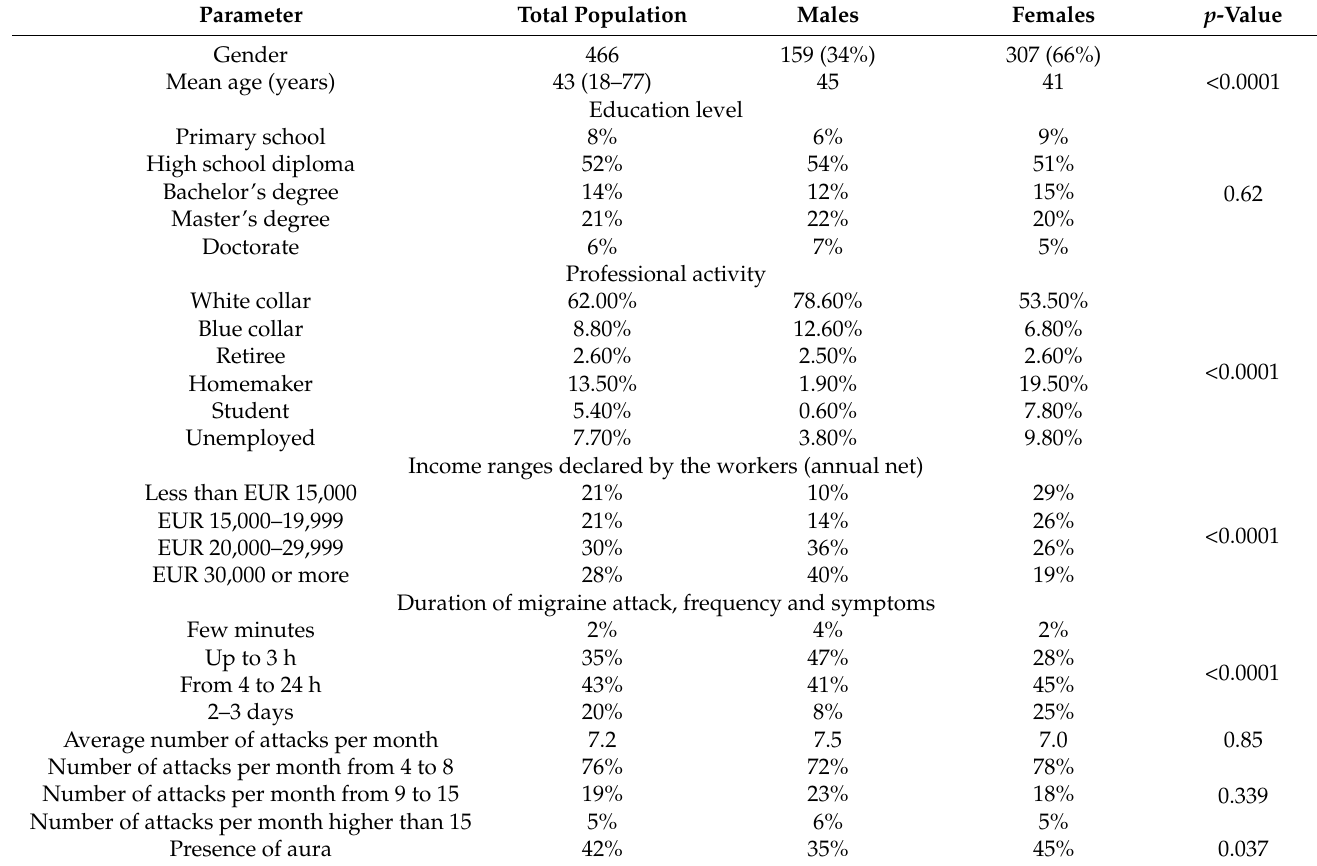
Table 2. Socio-demographic characteristics of the sample of respondents with the characteristics of migraine.